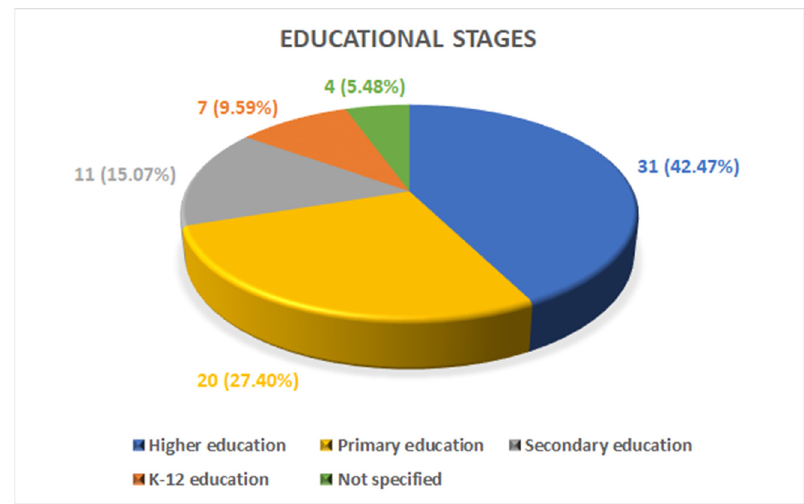
Figure 3. Empirical studies: educational stages.